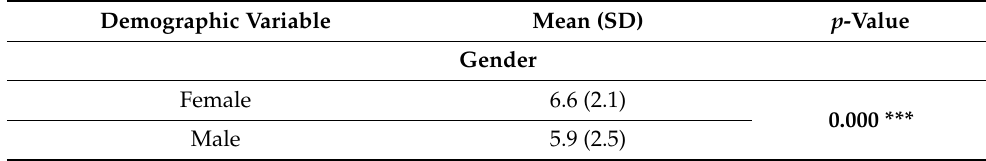
Table 2. Mean knowledge score stratified by demographic